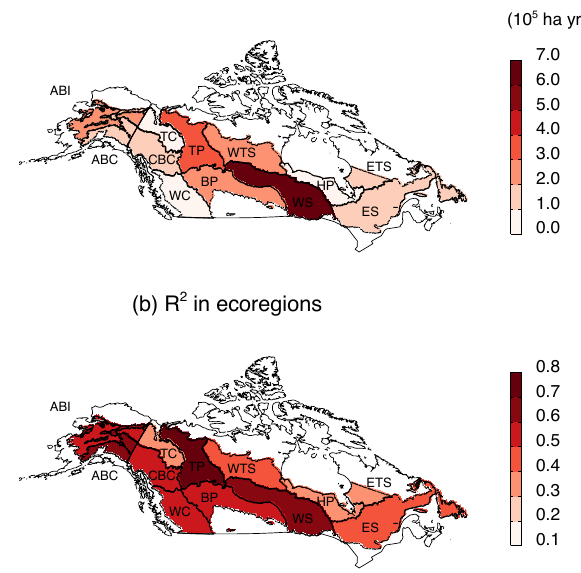
Figure 3. (a) Observed annual area burned and (b) fraction of the variance in observed area burned explained by the regression in each ecoregion for the period of 1980–2009 ( R 2 ) . The ecoregions are: Alaska Boreal Interior (ABI), Alaska Boreal Cordillera (ABC), Taiga Cordillera (TC), Canadian Boreal Cordillera (CBC), West- ern Cordillera (WC), Taiga Plain (TP), Boreal Plain (BP), West- ern Taiga Shield (WTS), Eastern Taiga Shield (ETS), Hudson Plain (HP), Western Mixed Wood Shield (WS), and Eastern Mixed Wood Shield (ES). Observations are compiled using fire reports from the Fire and Aviation Management Web Applications (FAMWEB) for Alaska and those from the Canadian National Fire Database (CNFD) for